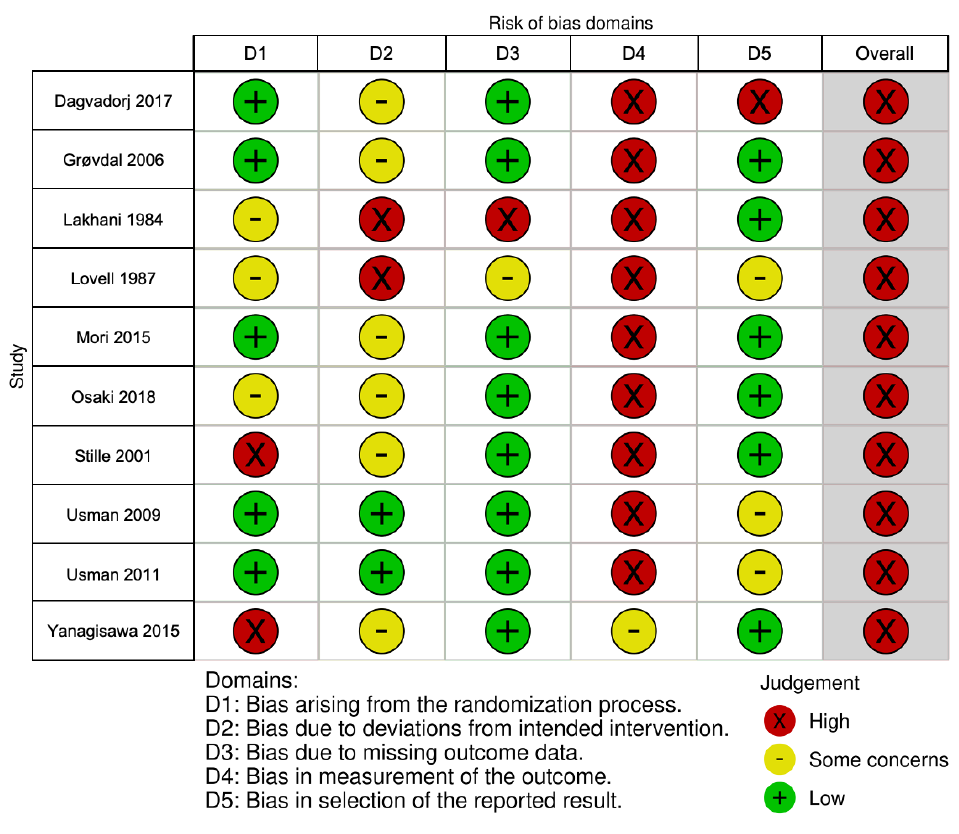
Figure 2. Risk of bias summary for randomized controlled trials based on authors’ judgments (low, some concerns, high) about each risk of bias item for each included study. some concerns, high) about each risk of bias item for each included